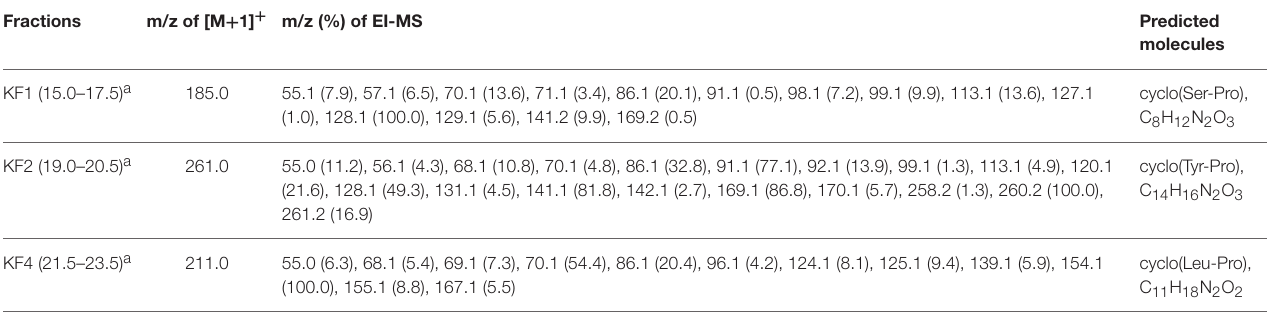
TABLE 5 | Mass analysis of fractions of kimchi filtrates from fermented kimchi inoculated with Ln. mesenteroides LBP-K06 by EI and CI using GC-MS. Fractions